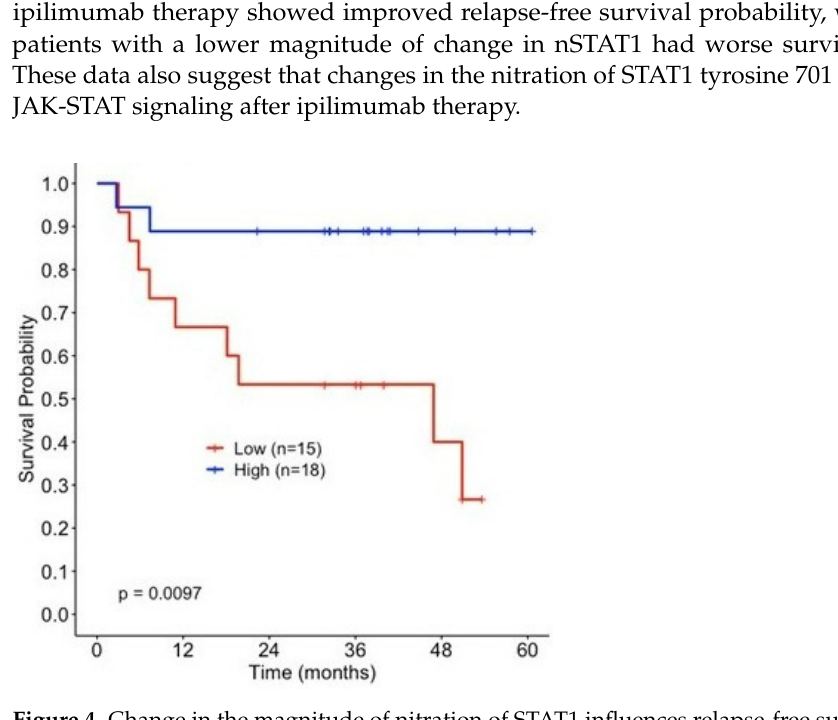
Figure 4. Change in the magnitude of nitration of STAT1 influences relapse-free survival (RFS) fol- lowing ipilimumab treatment. Kaplan–Meier survival estimates by change in nSTAT1 concentration, strati fi ed by the median (> − 0.004, low n = 15, high n = 18).